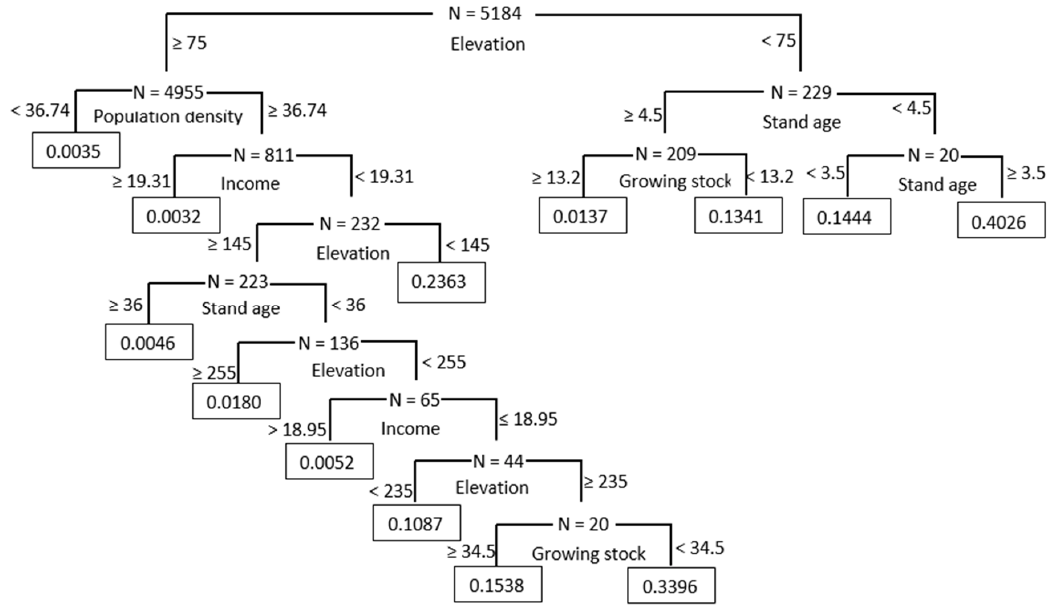
Figure 3. A regression tree to reflect most relevant factors affecting the abundance of invasive tree species in Mississippi from 2009 to 2015. species in Mississippi from 2009 to